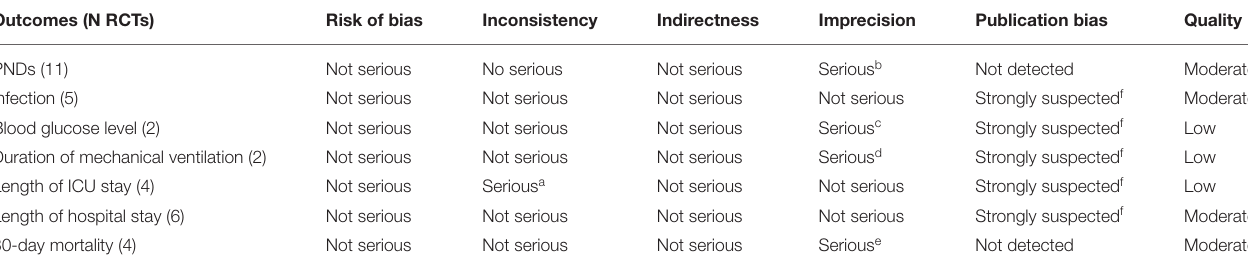
TABLE 2 | GRADE evidence for main